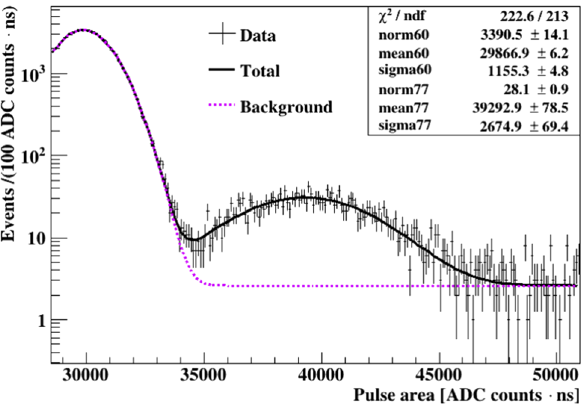
Fig. 9 Gaussian fitting of the 77 keV peak on top of a flat background and the tail of the 59.5 keV peak